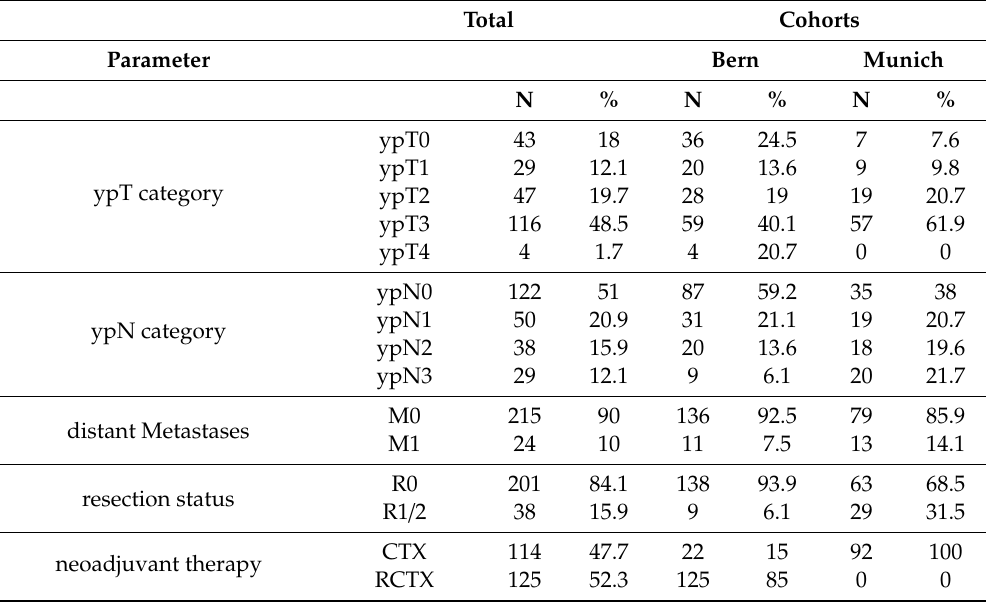
Table 1. Case cohorts and pathological